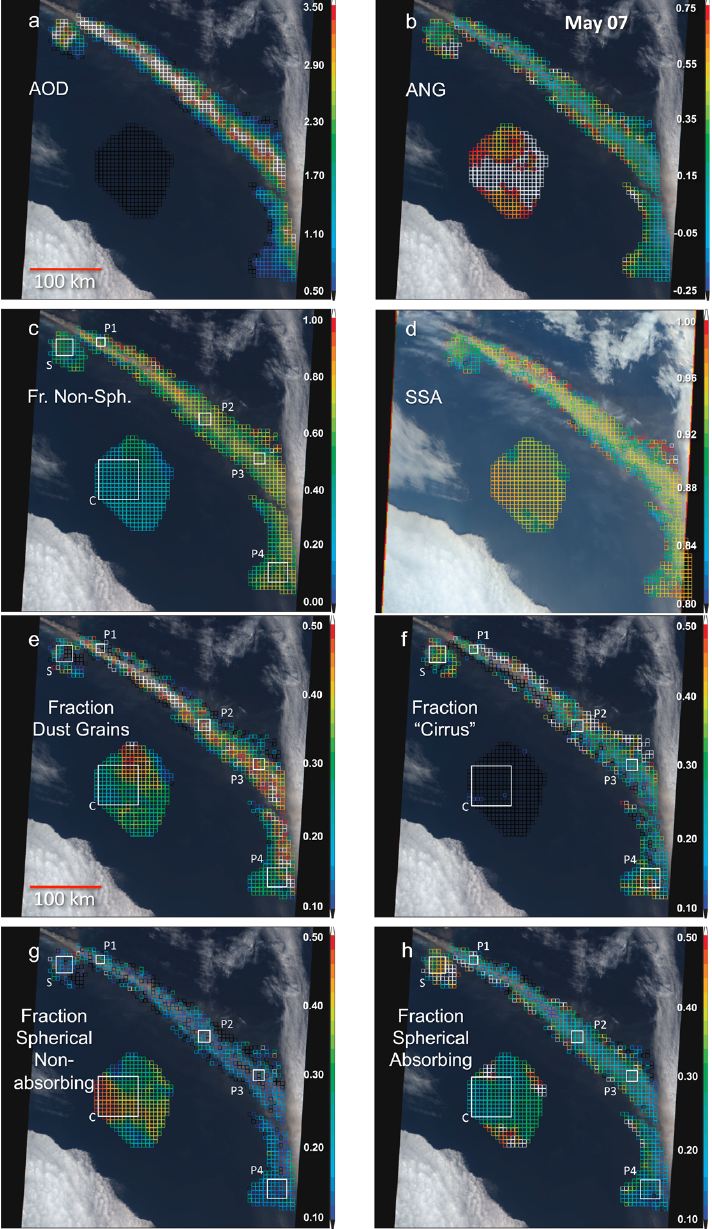
Fig. 3. MISR Research Retrieval results for the 7 May 2010 plume, superposed on MISR true-color imagery. (a) Aerosol optical depth (AOD 558 ) , (b) ˚Angstr¨om exponent (ANG), (c) Fraction AOD non-spherical, (d) single-scattering albedo (SSA 558 ) , (e) fraction AOD grains, (f) fraction AOD “cirrus”, (g) fraction AOD spherical non-absorbing particles, and (h) fraction AOD spherical absorbing particles. The volcano is in the upper left of these images, north is roughly toward the top, and the nadir image is shown in all but panel (d) , where the 70 ◦ forward view is given, to highlight aerosol detail and thin cloud adjacent to the main plume. For scale, the width of the swaths shown is about 380km. Two plumes appear, the main plume at about 5km elevation, extending to the SE, and a small plume of re-mobilized ash near the volcano itself, within 0.5km of the surface, that is blown to the SW (see Fig. 2a). The surface wind speed was set to 7.5ms − 1 , and for the main plume retrievals, the multi-angle images were co-registered to the approximate plume elevation. Retrievals were performed on regions comprised of 5 × 5 1.1km pixels over the main plume, the secondary plume, and in a control area to the west. The χ 2 for the retrievals in these images was set to p min +0.1. Retrieval results for Patch 2, one of six patches outlined in panel (c) , are summarized statistically in Fig. 4. An overview of Research Retrieval results for all six patches is given in Table